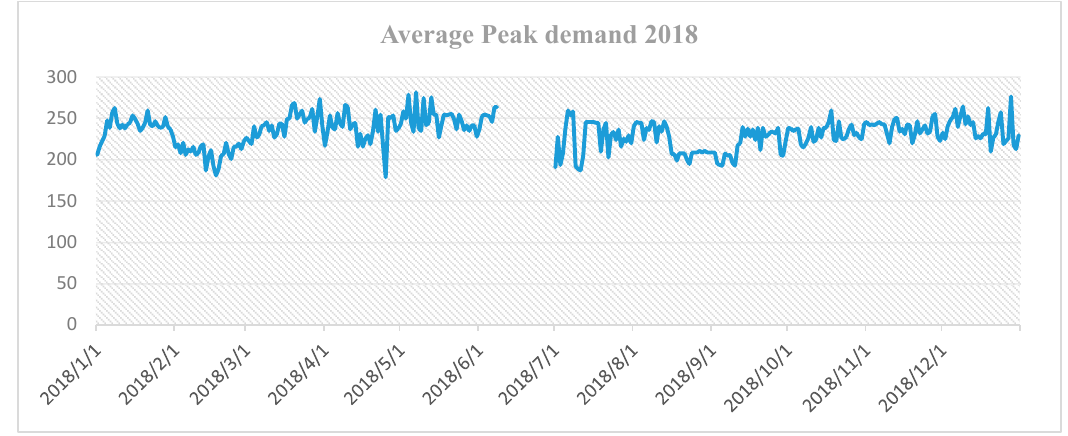
Figure 7. Simulated average peak demand for the year 2018.